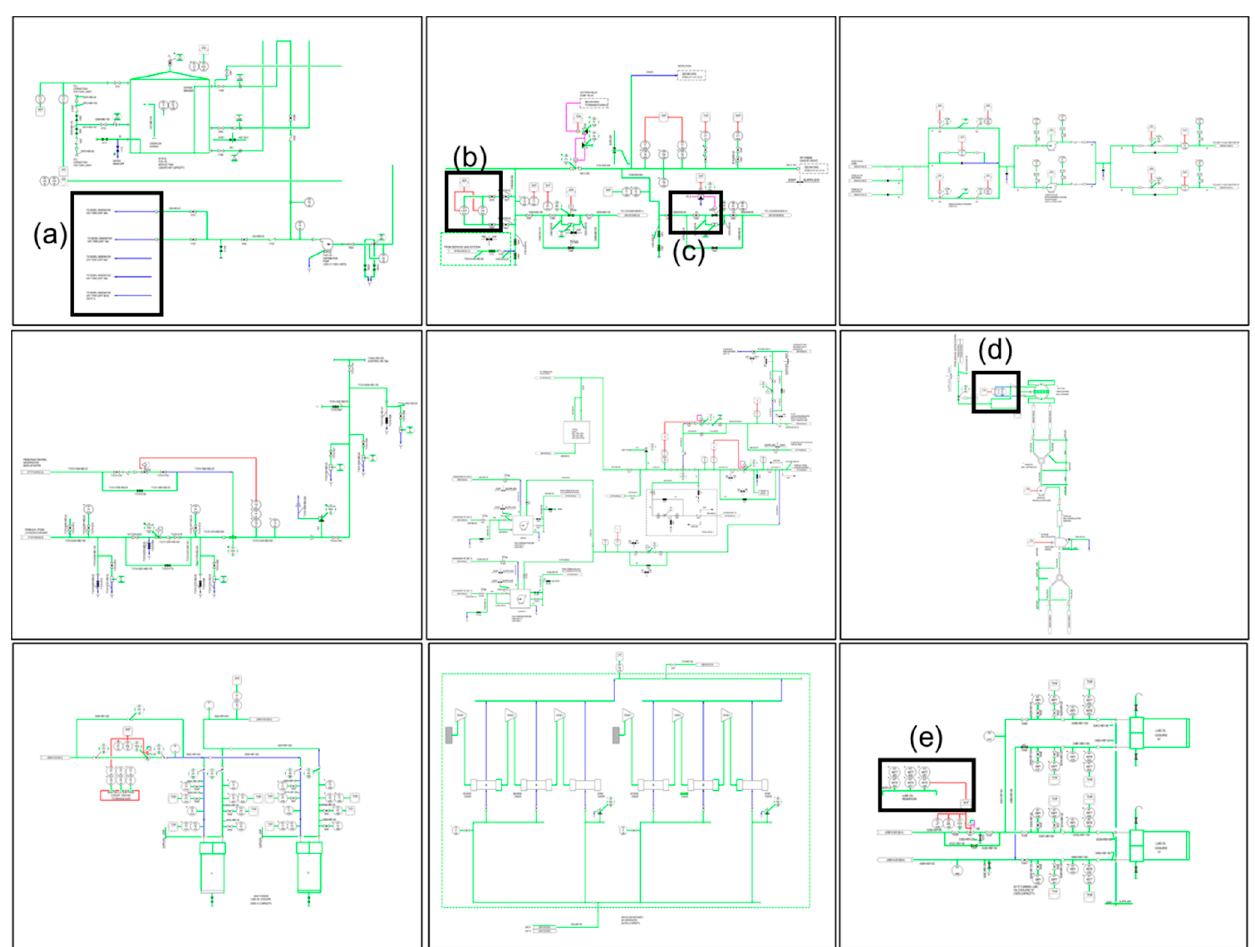
Figure 18. Test P&IDs used for the experiment.